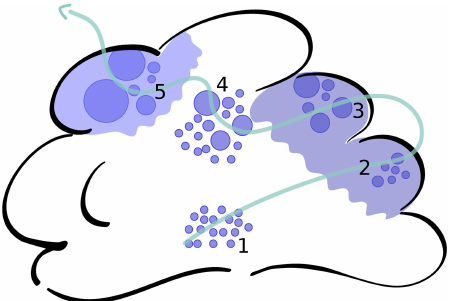
Figure 10. Schematic figure of the droplet growth for a recirculating